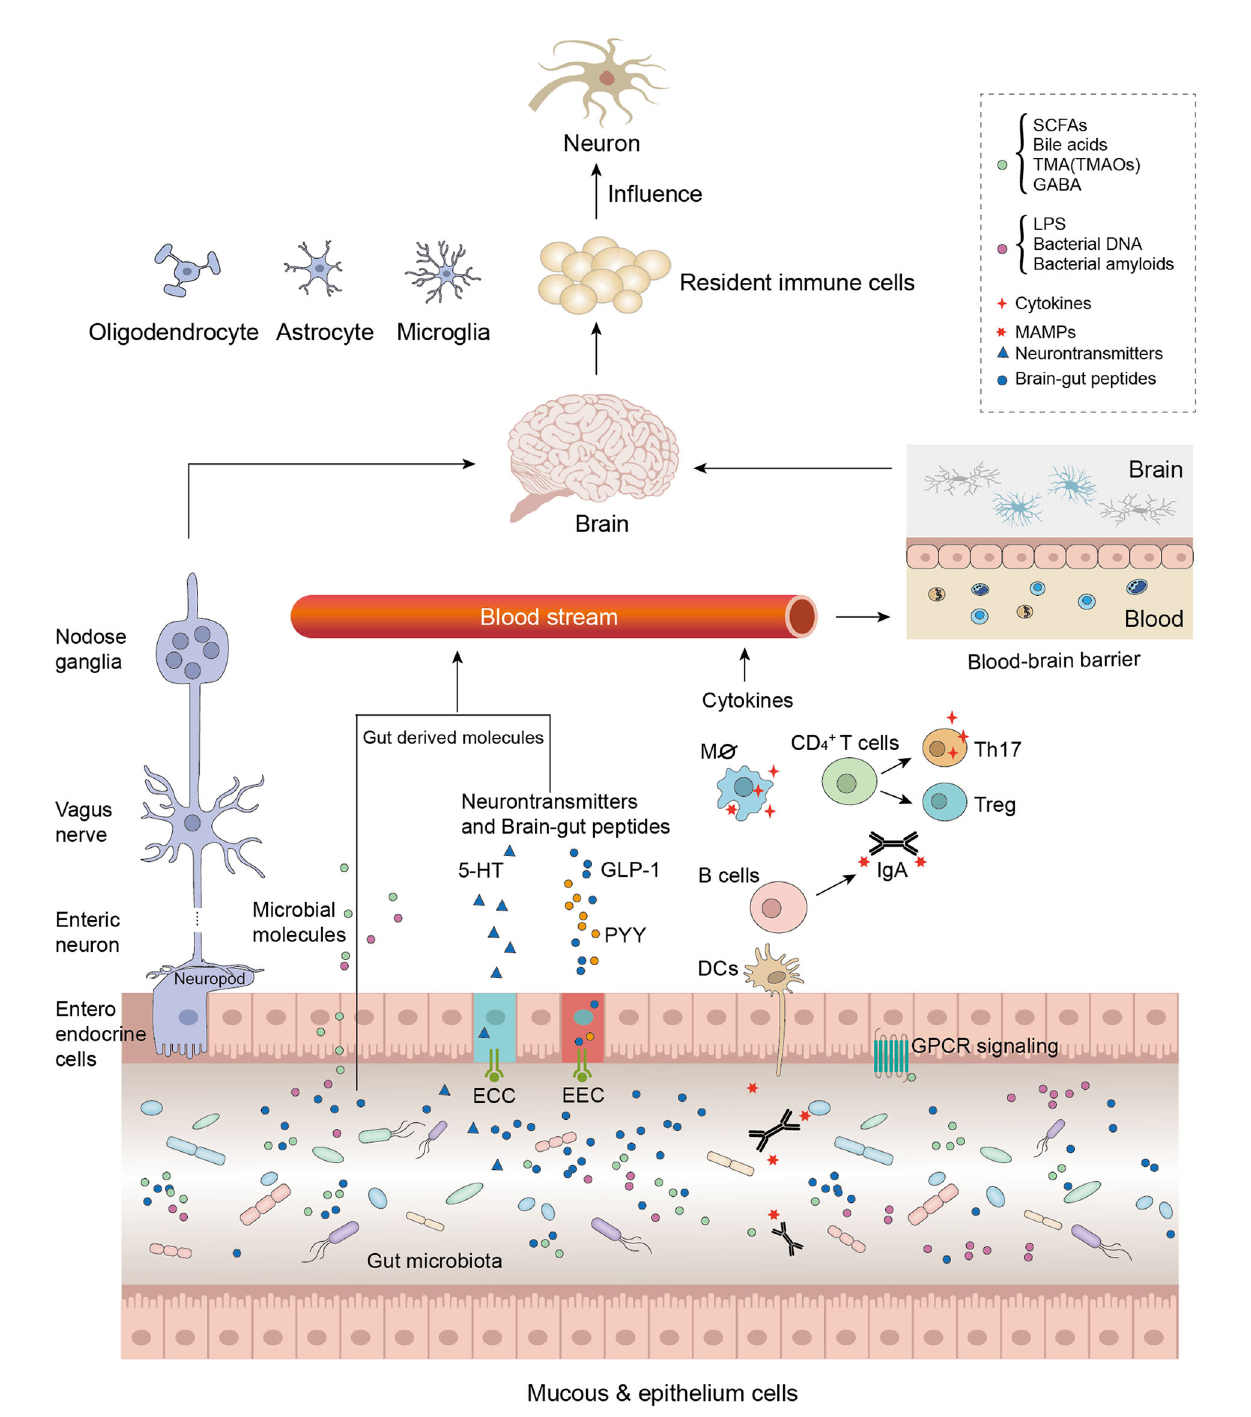
FIGURE 1 | Microbiota modulates the gut – brain axis through its secretions, including microorganism-associated molecular patterns (MAMPs) and microbial metabolites. As the intestinal permeability decreased due to the microbial molecules, these molecules were involved in generalized gut – brain signaling, such as the immune-modulating pathway, endocrine signaling pathway, the neural signaling pathway, and the neuroendocrine signaling pathway. Neurotransmitter-like substances such as gamma- aminobutyric acid (GABA) directly in fl uence the central nervous system (CNS) through nerve pathways; other gut-derived substances such as MAMPs and short-chain fatty acids (SCFAs) in fl uence the CNS by decreasing blood – brain barrier (BBB) permeability. Furthermore, these microbial molecules activate immune resident cells or neuron cells, which accelerate neurodegenerative disease (ND)